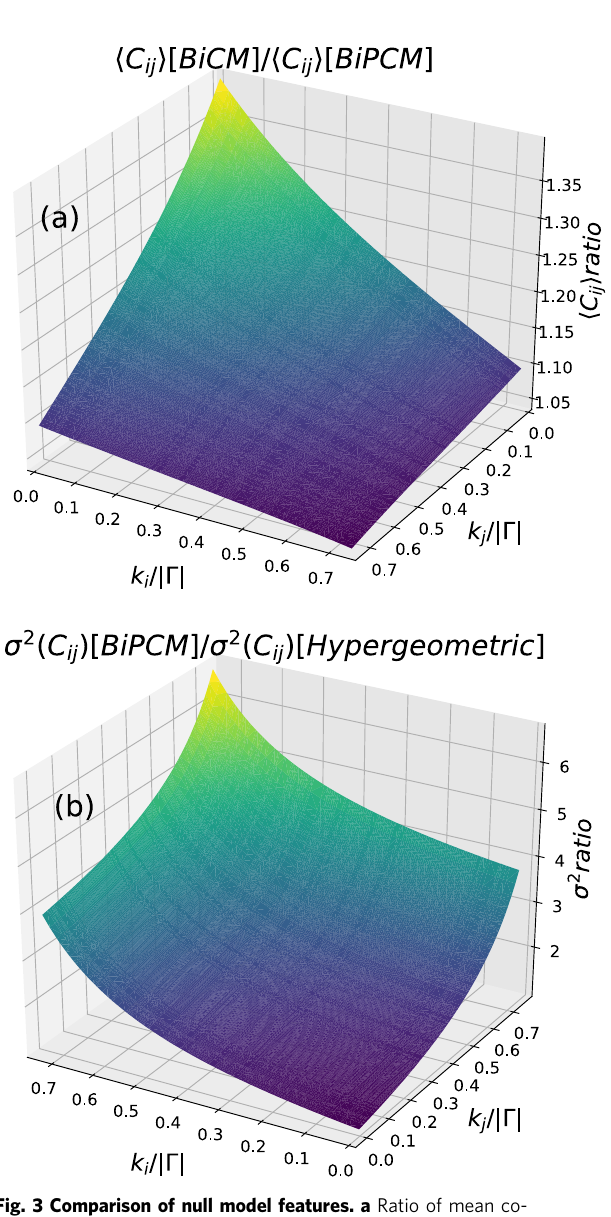
Fig. 3 Comparison of null model features. a Ratio of mean co- occurrences 〈 C ij 〉 for BiCM and BiPCM, and b ratio of variances σ 2 ( C ij ) for BiPCM and Hypergeometric, as a function of the normalized degrees k i / ∣ Γ ∣ and k j / ∣ Γ ∣ of the corresponding nodes. Both quantities are strongly dependent on the speci fi c model formulations, especially for high values of the